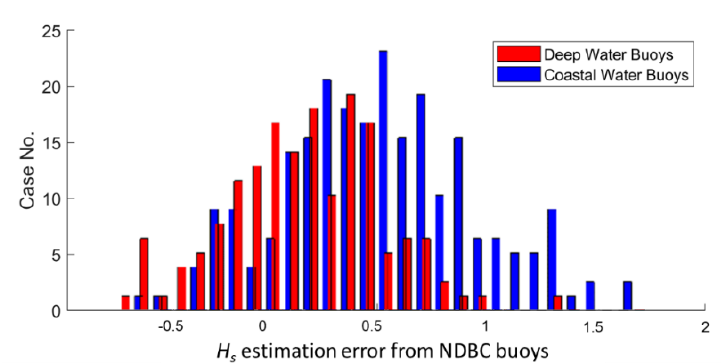
Figure 7. Distribution of H s estimation errors as compared with the NDBC buoy data for the coastal water and deep water.